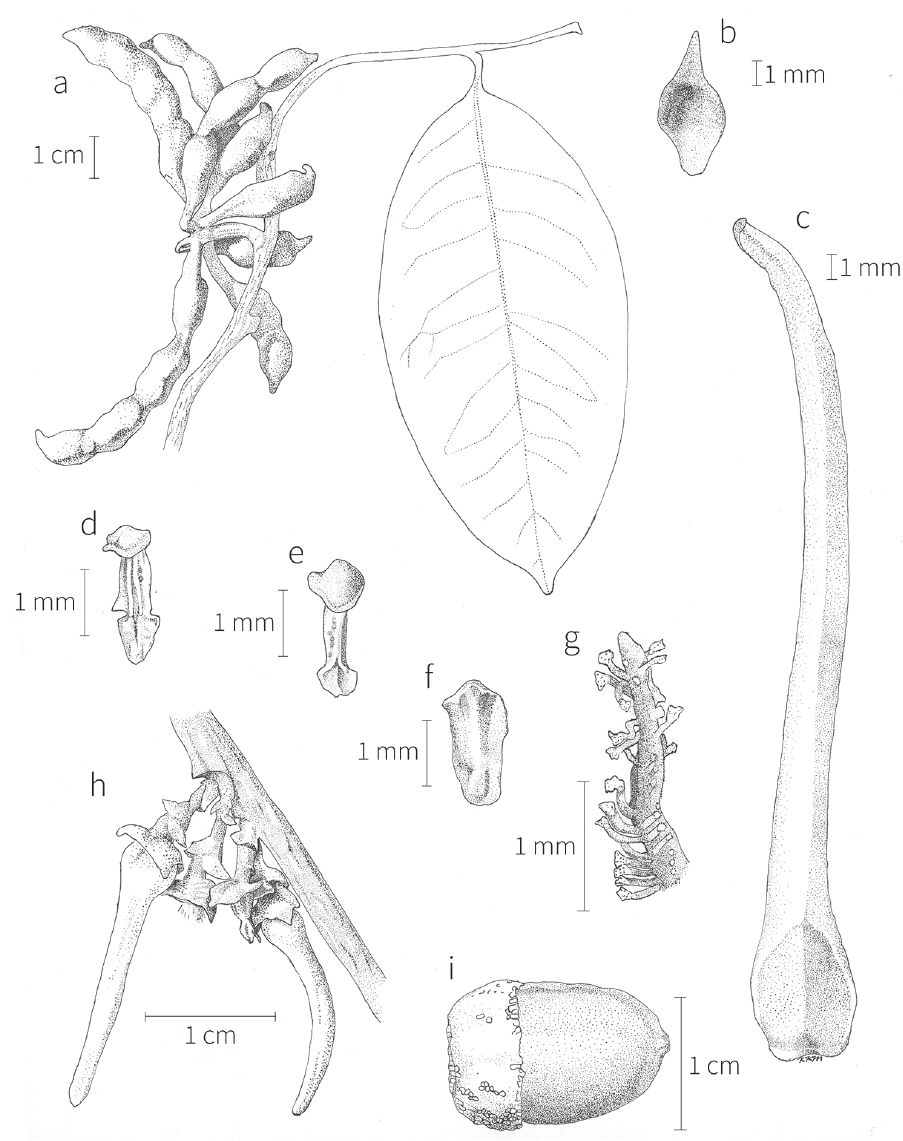
Figure 11. Xylopia rubescens . A Habit with fruit B Inner petal, adaxial surface C Outer petal, adaxial surface D, E Stamens, abaxial view F Staminode, abaxial view G Stigma apex H Inflorescence I Seed, longitudinal view. A from Brenan et al. 8022 (K), B–H from Angus 870 (MO) I from Breteler et al. 10446 (WAG, spirit